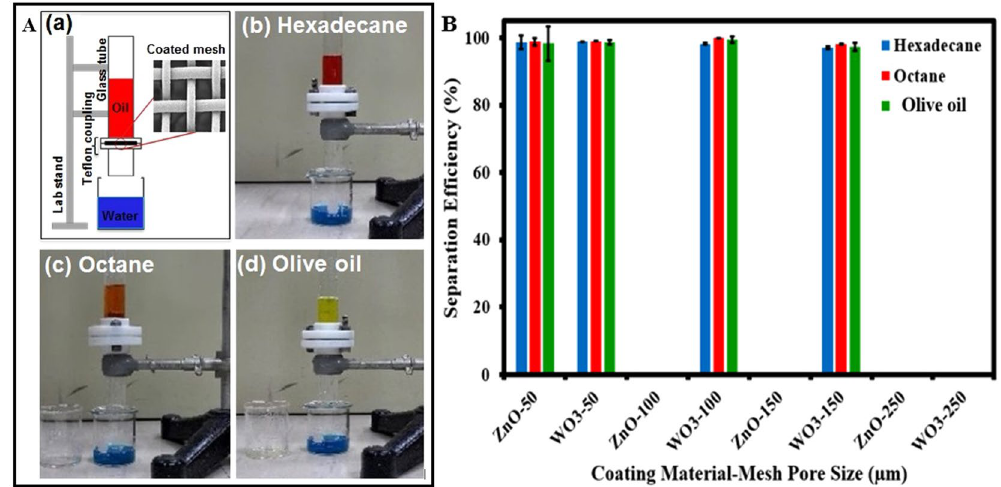
Figure 3. ( A ) (a) Schematic diagram of oil-water separation system, (b), (c) and (d) are pictorial views of oil − water separation setup using WO 3 coated mesh (100 micron pore size) for hexadecane, octane and olive oil respectively. The oils are colored with the red/yellow, while water is colored with the methylene blue dye. As a result of the exceptional underwater superoleophobic behavior of the WO 3 coated mesh, water passed through these meshes while retaining oil above and we observed that the permeated water in this process is practically free from any traces of oil and also the filtration process was quite fast. ( B ) The separation efficiency of ZnO and WO 3 coated meshes with pore sizes of 50, 100, 150 and 250 µ m for hexadecane, octane and olive oil. Both WO 3 and ZnO the coatings show about 99% efficiency in oil water separation, the WO 3 coated membrane is usable with the stainless steel mesh pore size up to 152 µ m, while maximum pore size for ZnO coated mesh can handle is only 50 µ m. In the case of ZnO coated membrane, when the pore size above 50 µ m was used, the oil water separation failed while, in the case of WO 3 coated membrane, the oil-water separation is possible for the mesh of pore size as large as 150 µ